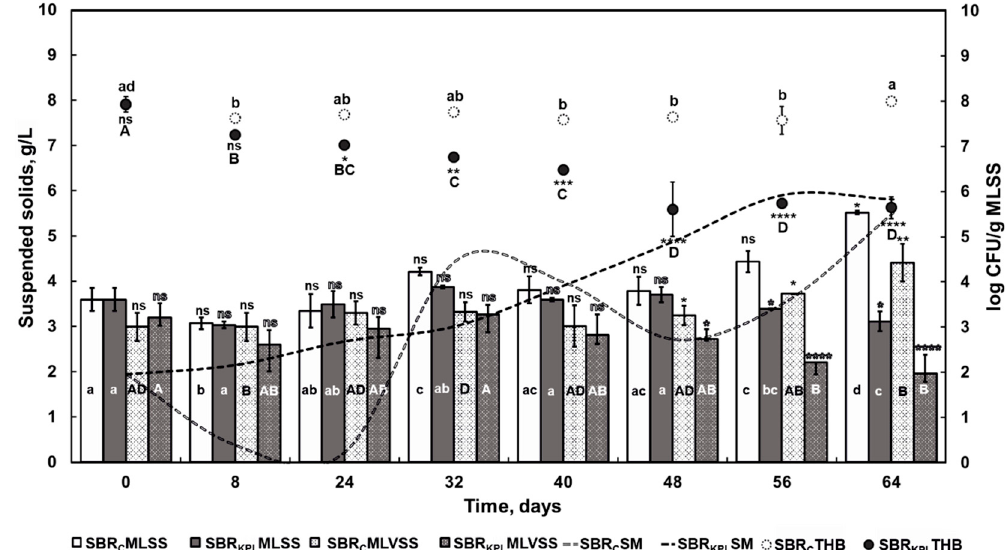
Figure 4. The changes in the MLSS, MLVSS, suspended matter (SM), and number of heterotrophic bacteria (THB) in the SBR C and SBR KPL during 64 days of wastewater treatment.